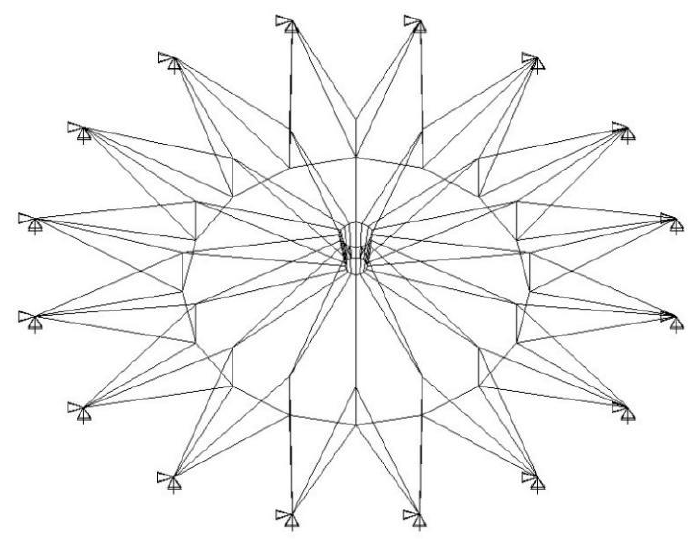
Figure 3. Optimisation of the cable arrangement.